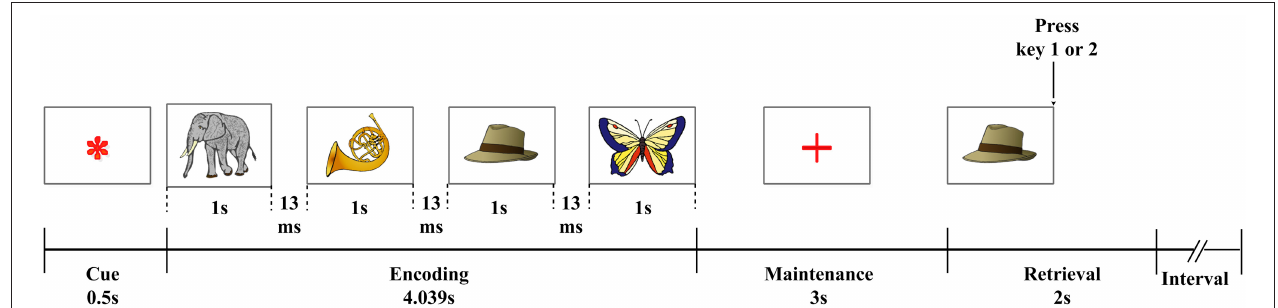
FIGURE 1 | Visual WM paradigm. An asterisk (*), serving as a fixation point, was shown for 0.5s; four pictures from a memory set were then sequentially presented for 1s each, separated by an interval of 0.013s. This was followed by a 3-s maintenance phase, after which a probe image was shown to the subject. Then there was 2s for the subject to decide whether the probe image was presented among the initial four images from the memory set (Pan et al.,